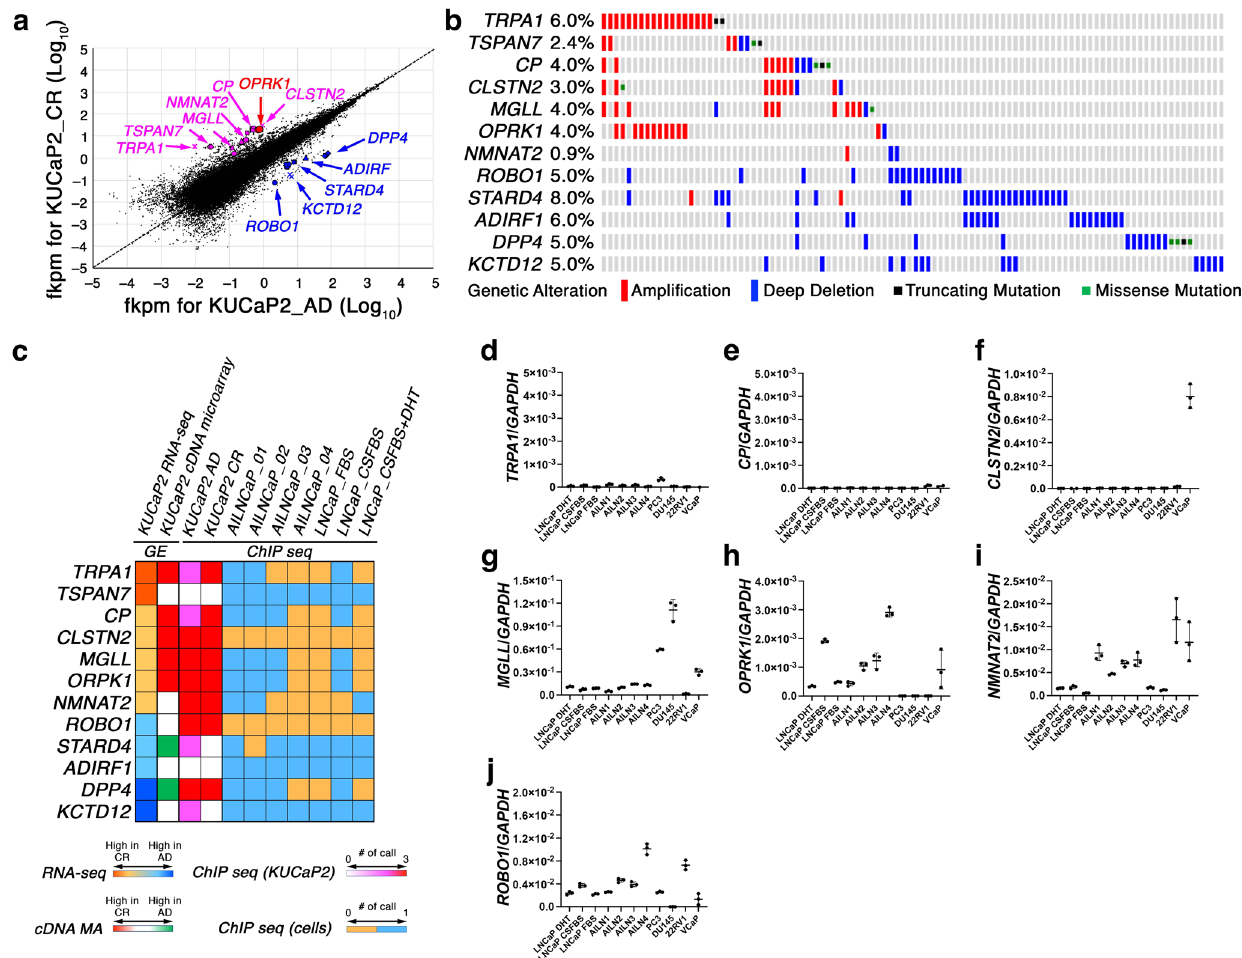
Fig. 3 RNA sequence KUCaP2 AD and CR tumors. Among 30 most signi fi cantly upregulated genes in RNA seq of KUCaP2 CR compared with AD tumors, seven genes that were reported to be frequently ampli fi ed in PCa were picked up. Likewise, among 30 most signi fi cantly downregulated genes in KUCaP2 CR tumors, fi ve genes that were reported to be frequently altered (deep deletion, and truncating and missense mutations) in CRPC were picked up. a Dot plot of log 10 [fkpm] indicating the 12 genes. b Landscape of alterations (ampli fi cation, deep deletion, and truncating and missense mutations) of the 12 genes primary PCa 24 . c Summarized results from integrated genomics including RNA seq of KUCaP2 tumors (AD vs CR), cDNA microarray of KUCaP2 tumors (AD vs CR) 16 , ChIP seq of KUCaP2 tumors (AD and CR), and ChIP seq of AILNCaPs (four independent sublines) and LNCaP cells cultured in FBS (LNCaP_FBS), charcoal-stripped FBS (LNCaP_CSFBS), and CSFBS supplemented with 1 nM dihydrotestosterone (LNCaP_CSFBS + DHT). d – j Quantitative RT-PCR in human PCa cell lines. Expressions of TRPA1 ( d ), CP ( e ), CLSTN2 ( f ), MGLL ( g ), OPRK1 ( h ), NMNAT2 ( i ), and ROBO1 ( j ) normalized by that of GAPDH in the indicated PCa cell